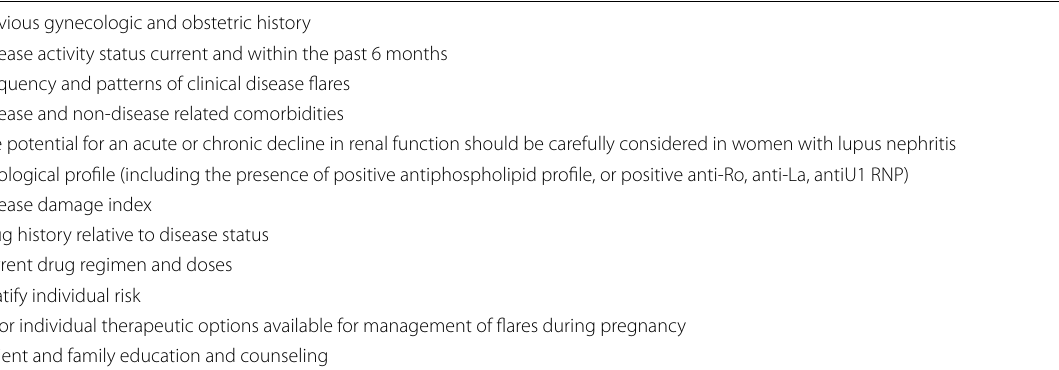
Table 1 Pivotal individualized preconception assessment needs in pregnancy with lupus Previous gynecologic and obstetric history Disease activity status current and within the past 6 months Frequency and patterns of clinical disease flares Disease and non-disease related comorbidities The potential for an acute or chronic decline in renal function should be carefully considered in women with lupus nephritis Serological profile (including the presence of positive antiphospholipid profile, or positive anti-Ro, anti-La, antiU1 RNP) Disease damage index Drug history relative to disease status Current drug regimen and doses Tailor individual therapeutic options available for management of flares during pregnancy Patient and family education and